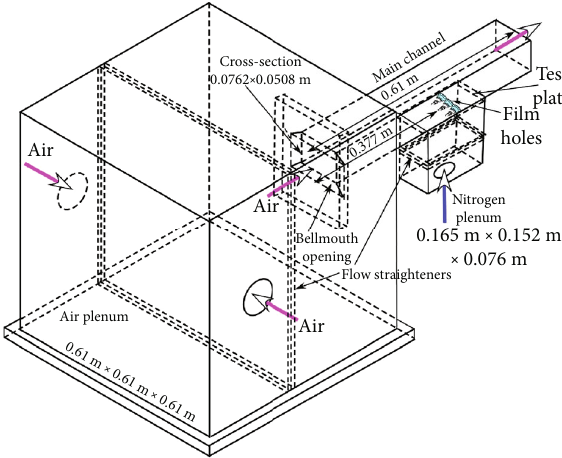
Figure 4: Schematics of the test rig.